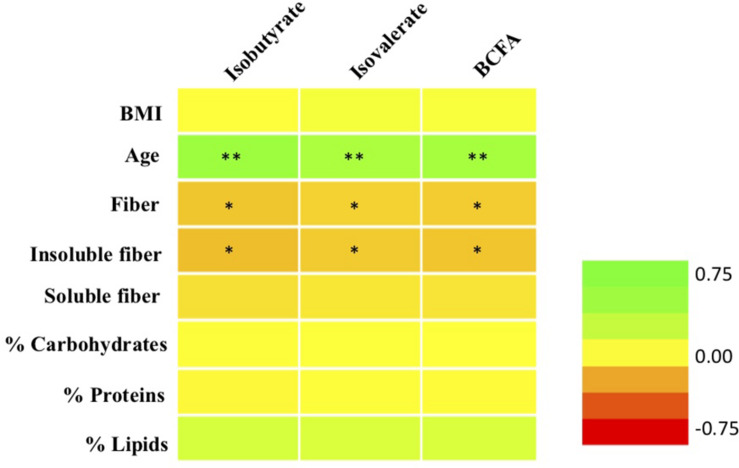
Correlations between molar proportions of BCFA (total BCFA, isobutyrate, isovalerate) with age, BMI, and daily dietary intake of macronutrients and fiber. ∗p < 0.05; ∗∗p < 0.01. Green, positive correlations; orange-red, negative correlations.